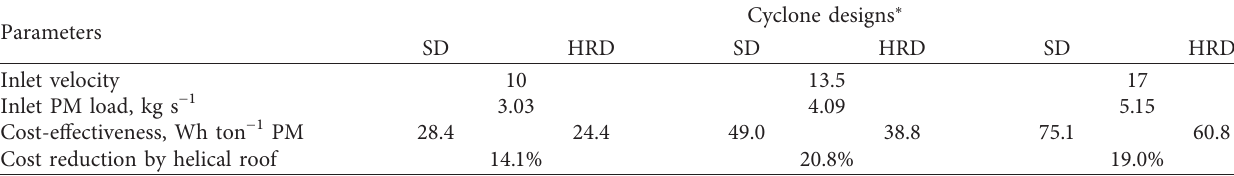
Table 3: Calculated cost-effectiveness for standard roof and helical roof